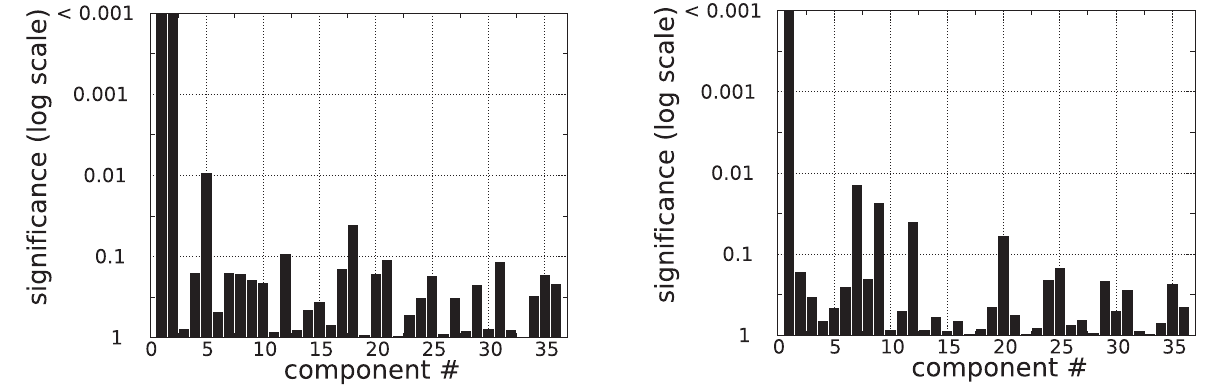
Figure 7. MDS: Component-wise effect of method (left) and condition (right). For each component and corresponding significance level P , we represented { log 10 ( P ) .